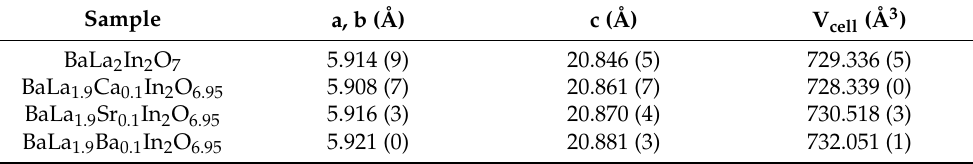
Table 1. Lattice parameters and unit cell volume for the investigated